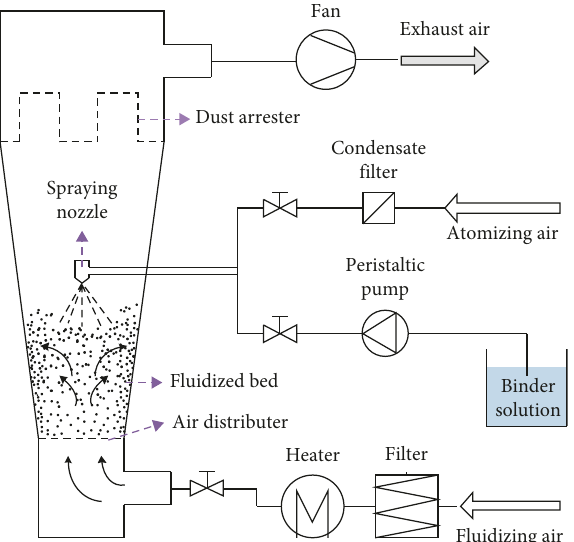
Figure 2: Schematic diagram of a top-spray fluidized bed granulator.